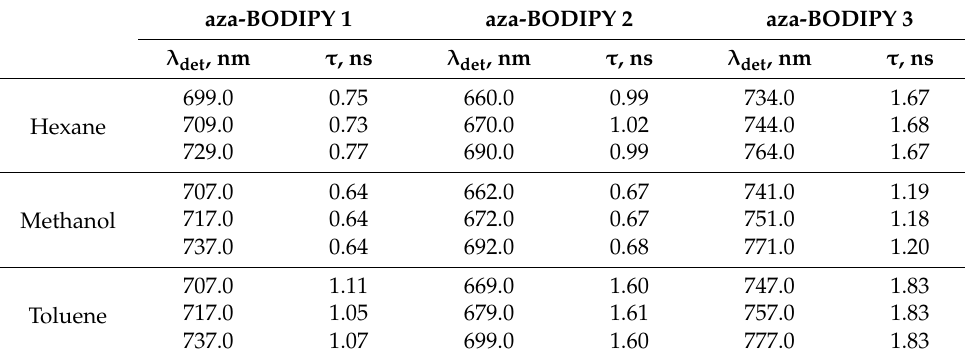
Table 3. Fluorescence lifetimes of aza-BODIPYs 1–3, measured at different wavelengths in cyclohexane, methanol, and toluene: λ det —detection wavelength, nm; τ —fluorescence lifetime at 293 K, ns. aza-BODIPY